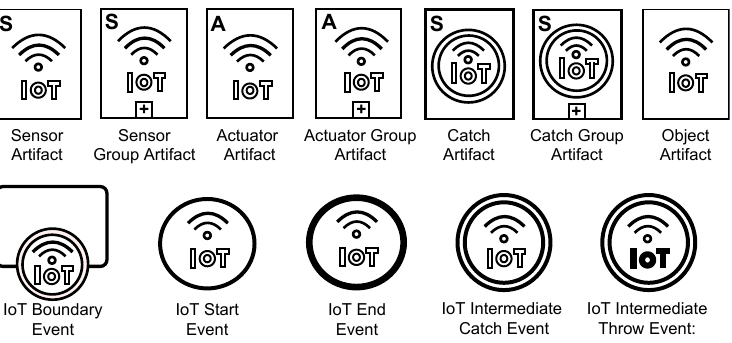
Figure 4. BPMNE4IoT with the notation of the IoT-specific modeling elements.